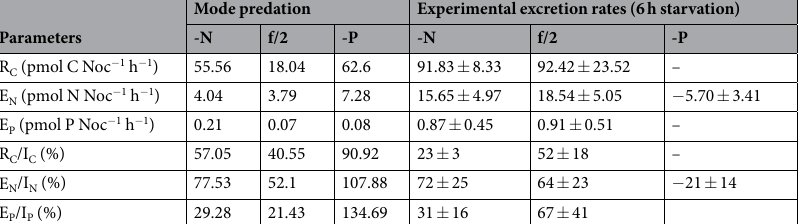
Table 4. Computational and experimental excretion rates of C, N and P (R C , E N and E P , pmol Noc − 1 h − 1 ) and percentages of the excretion to ingestion (%) of Noctiluca scintillans grown on N-limited (-N), nutrient- balanced (f/2) and P-limited (-P) Thalassiosira weissflogii . Note: In the starvation experiment, percentages of the excretion to ingestion (%) of Noctiluca were calculated by dividing the elemental excretion in 6 h to 1-day ingestion and assuming that Noctiluca ’s assimilation efficiency was 60% for C content in all food treatments, 80% for the excessive nutrient and 100% for the limited nutrient. Dashes mean no significance difference of the element content of Noctiluca before and after